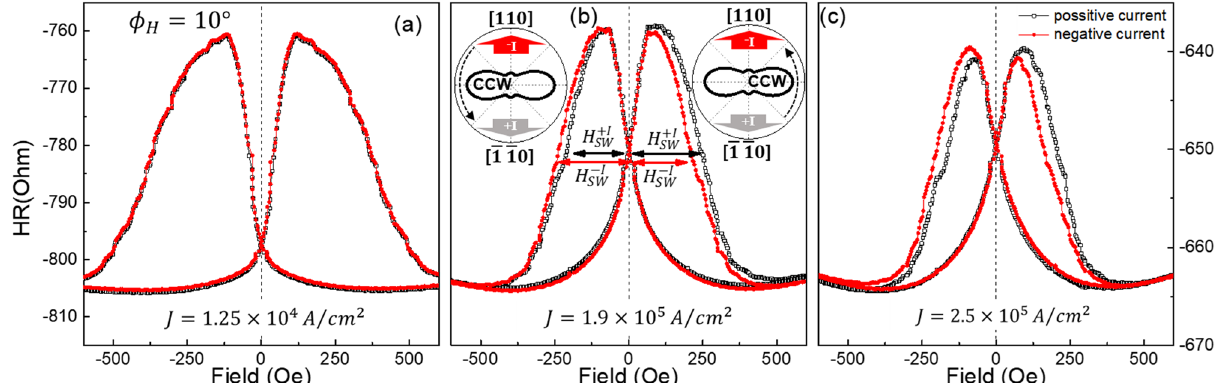
◦ for three different current densities. 110 110 and the energy barrier in negative and (cid:31) (cid:31) (cid:30) (cid:30)